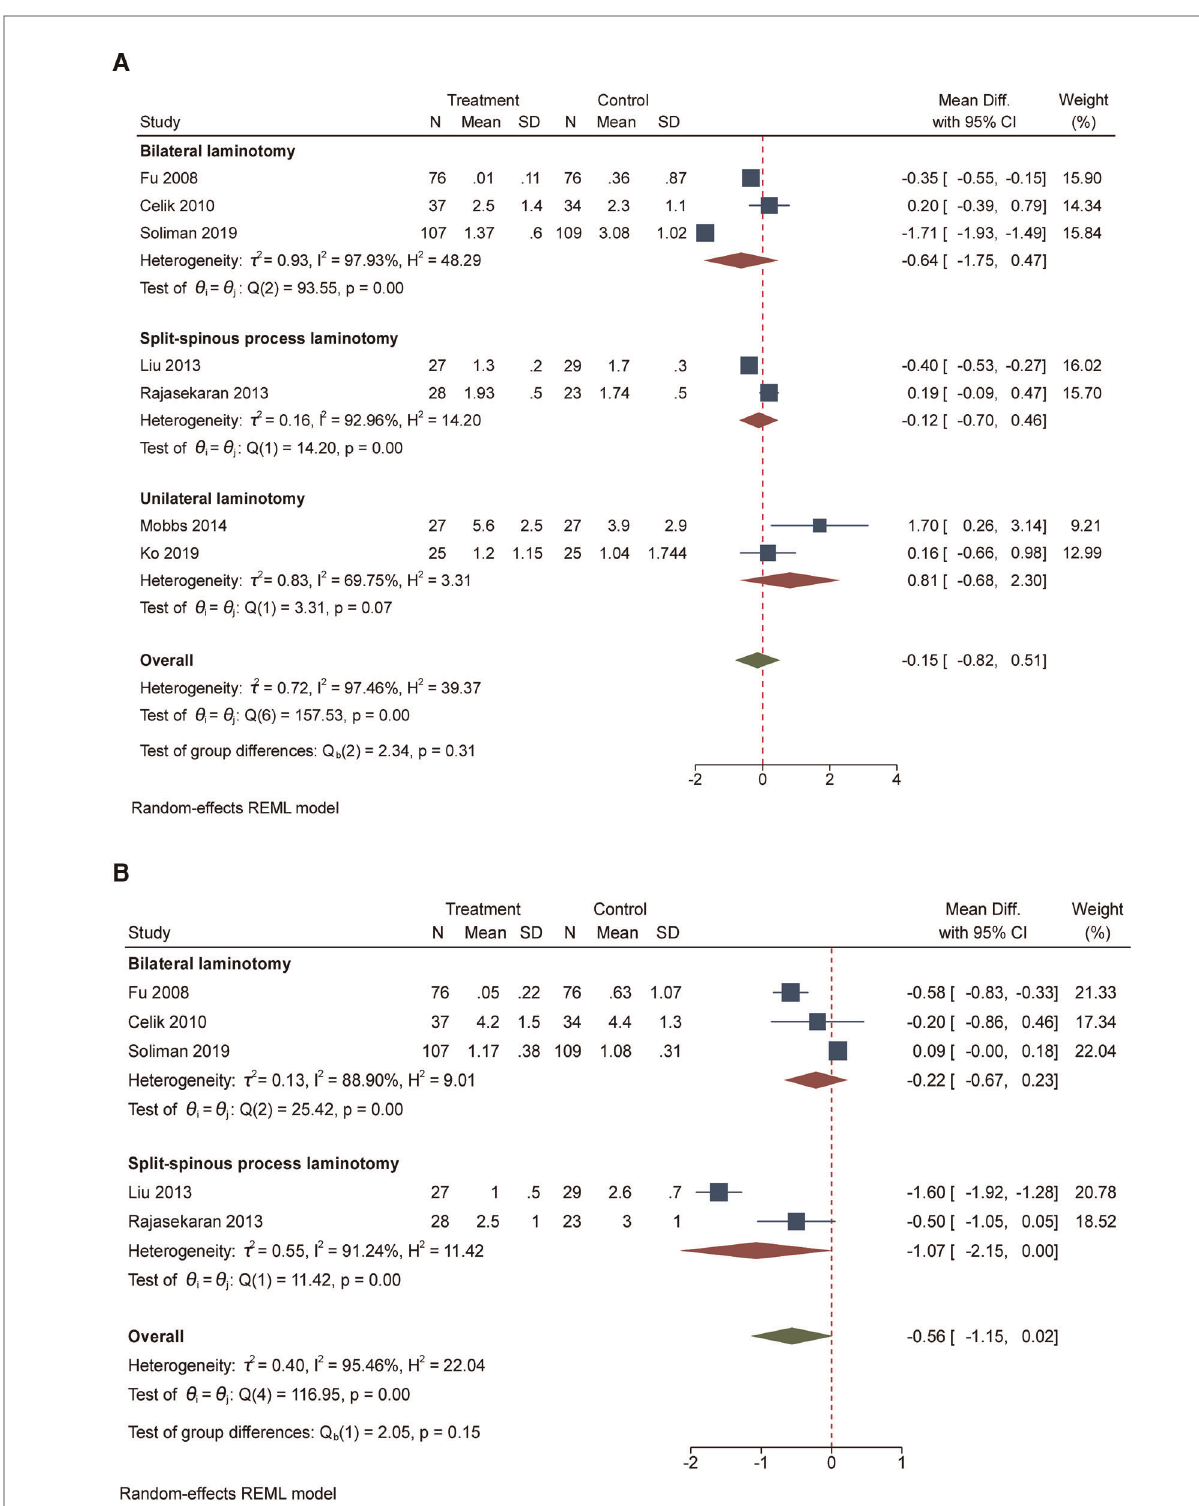
FIGURE 3 ( A ) The forest plot regarding leg pain compared posterior techniques with tourniquet group. ( B ) The forest plot regarding back pain compared posterior techniques with tourniquet